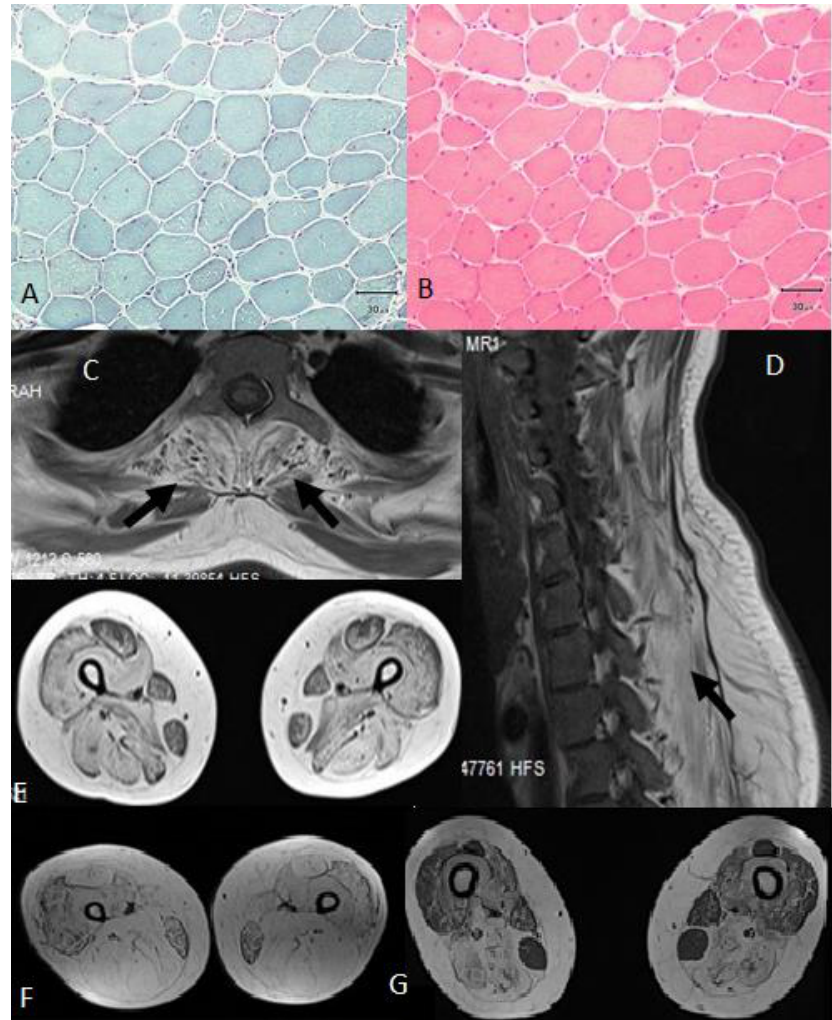
Figure 3. ( A ) and ( B ) A muscle biopsy from the deltoid muscle of patient D showed myopathic changes with increased numbers of internal nuclei (over 10%) and with a few angular atrophic fibers; ( C ), ( D ) and ( E ) A muscle MRI of patient D showed paraspinal muscle involvement and good preservation of the sartorius and gracilis muscles in the lower limbs. ( F ) The muscle MRI of patient A showed advanced fatty transformation, but fairly good preservation of the gracilis muscles. ( G ) The muscle MRI of patient B showed clear pathology of the adductor magnus, adductor longus, biceps femoris, semitendinosus, and semimembranosus muscles and sparing of the gracilis muscles with good preservation of the rectus femoris and sartorius